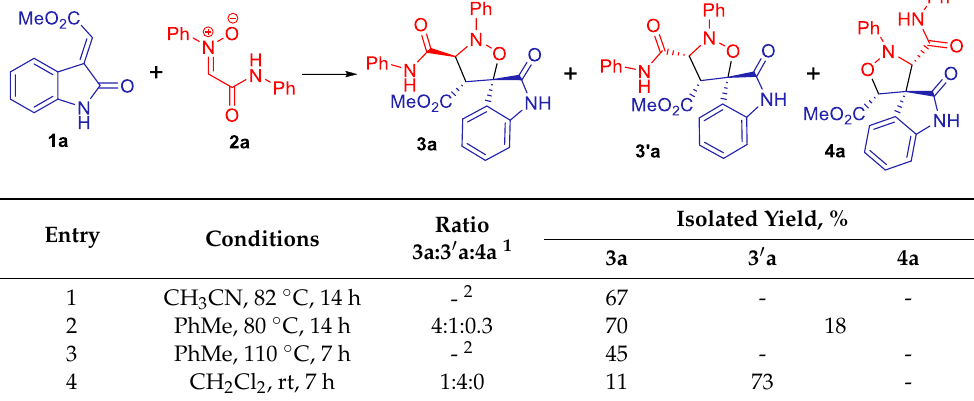
Table 1. Optimization of cycloaddition reaction conditions.